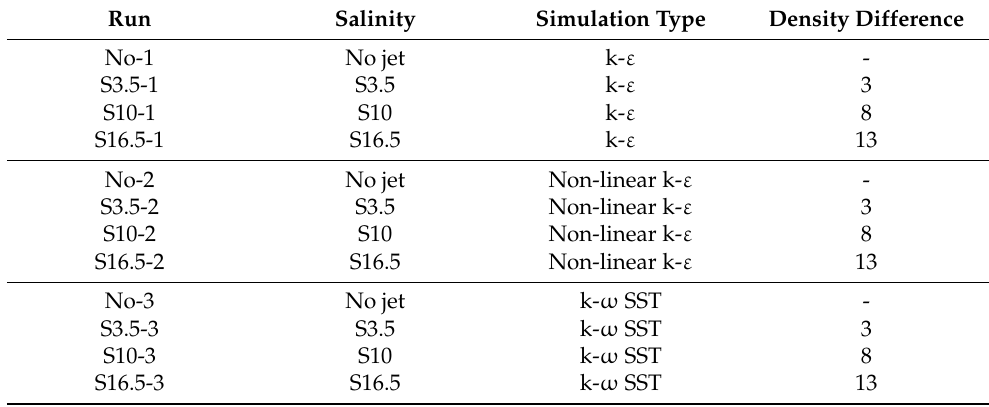
Table 2. Parameters of the simulated cases.